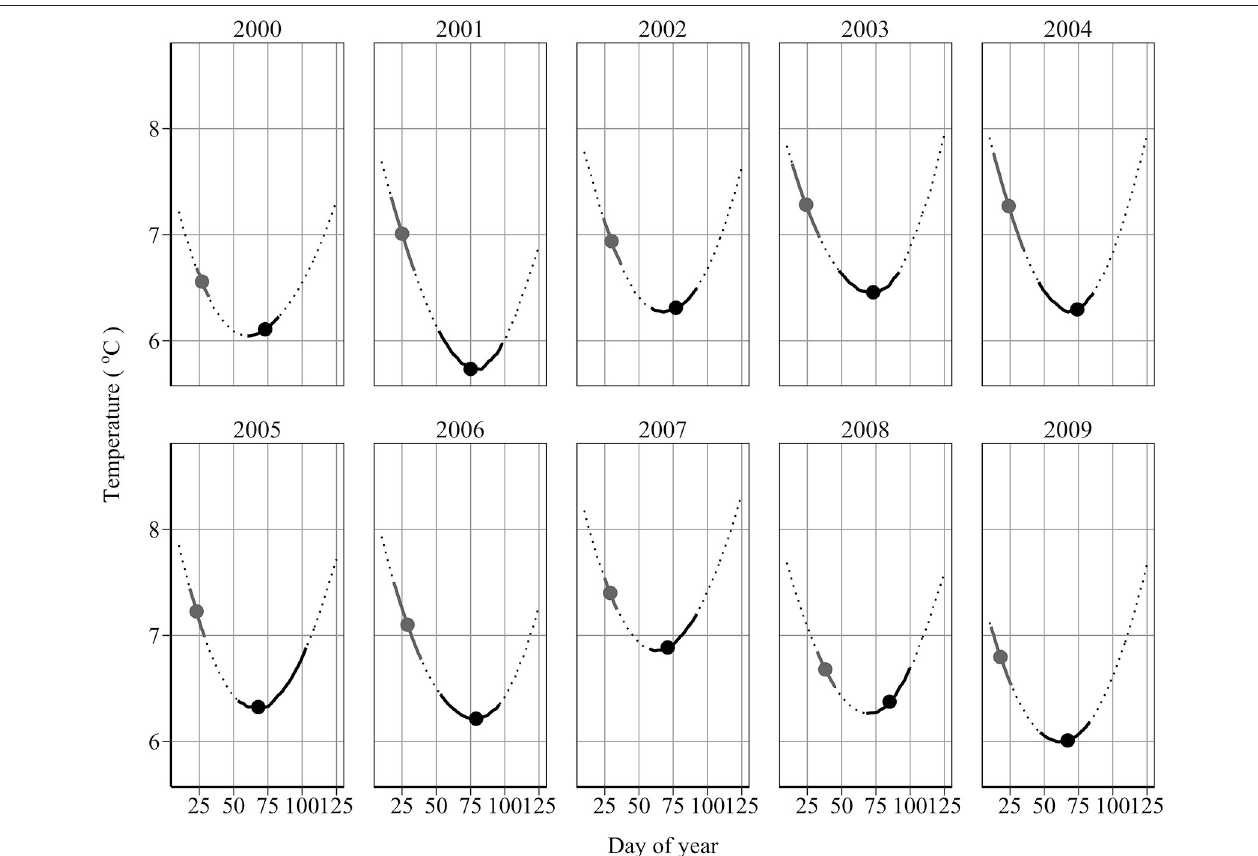
FIGURE 5 | Spawning and hatch dates in relation to temperature. Shown is the temperature profile at 45m depth (dotted line) with overlaid spawning and hatch dates between 10th January and 1st May. Filled circles denote the mean spawning and median hatch dates, respectively. Solid black lines denote the spawning and hatch intervals,